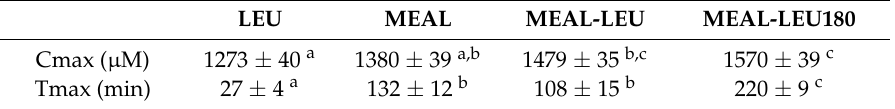
Table 4. Plasma essential amino acid concentration of the pharmacokinetics parameters.